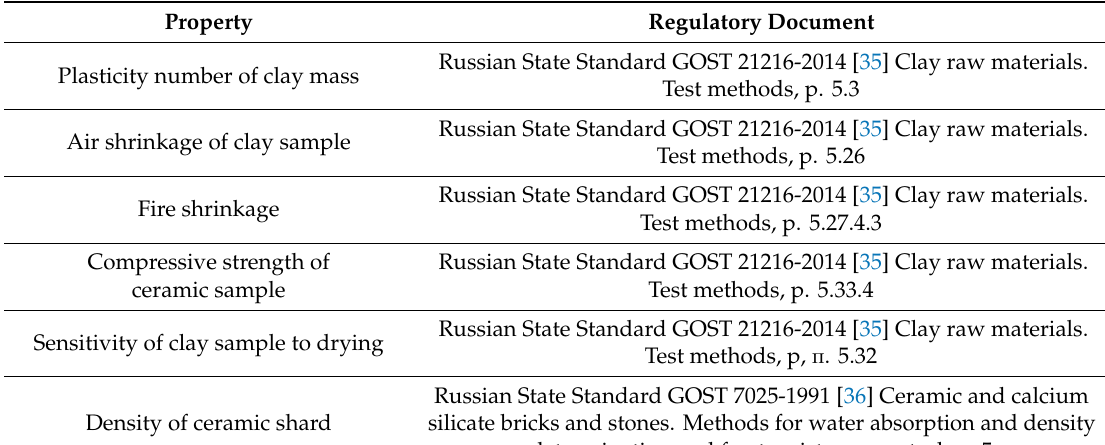
Table 1. Testing Table 1. Testing methods.